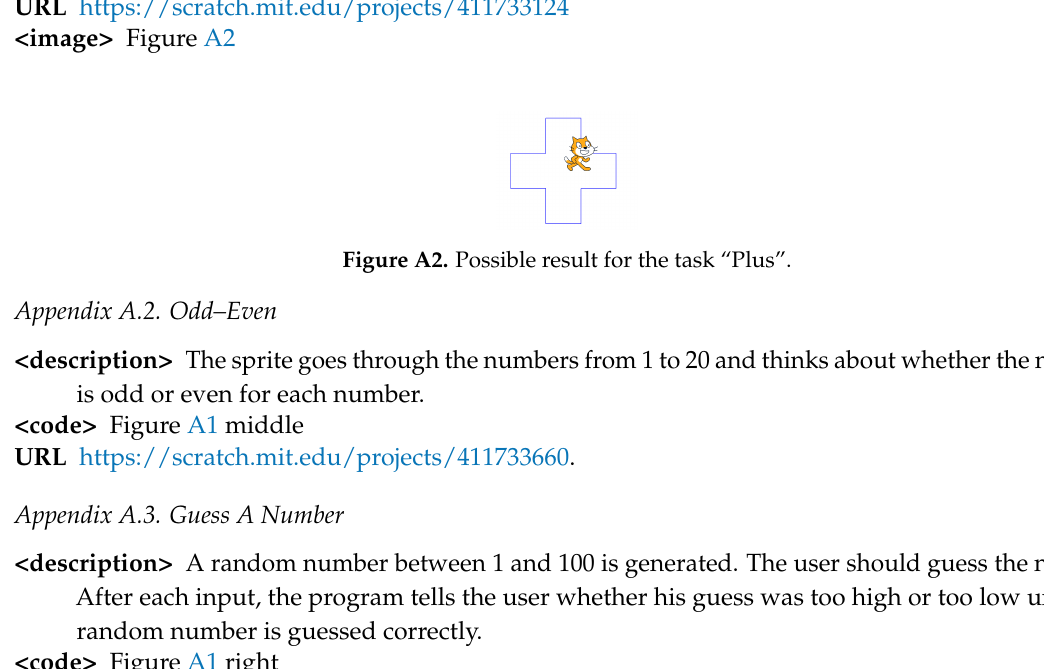
Figure A2. Possible result for the task